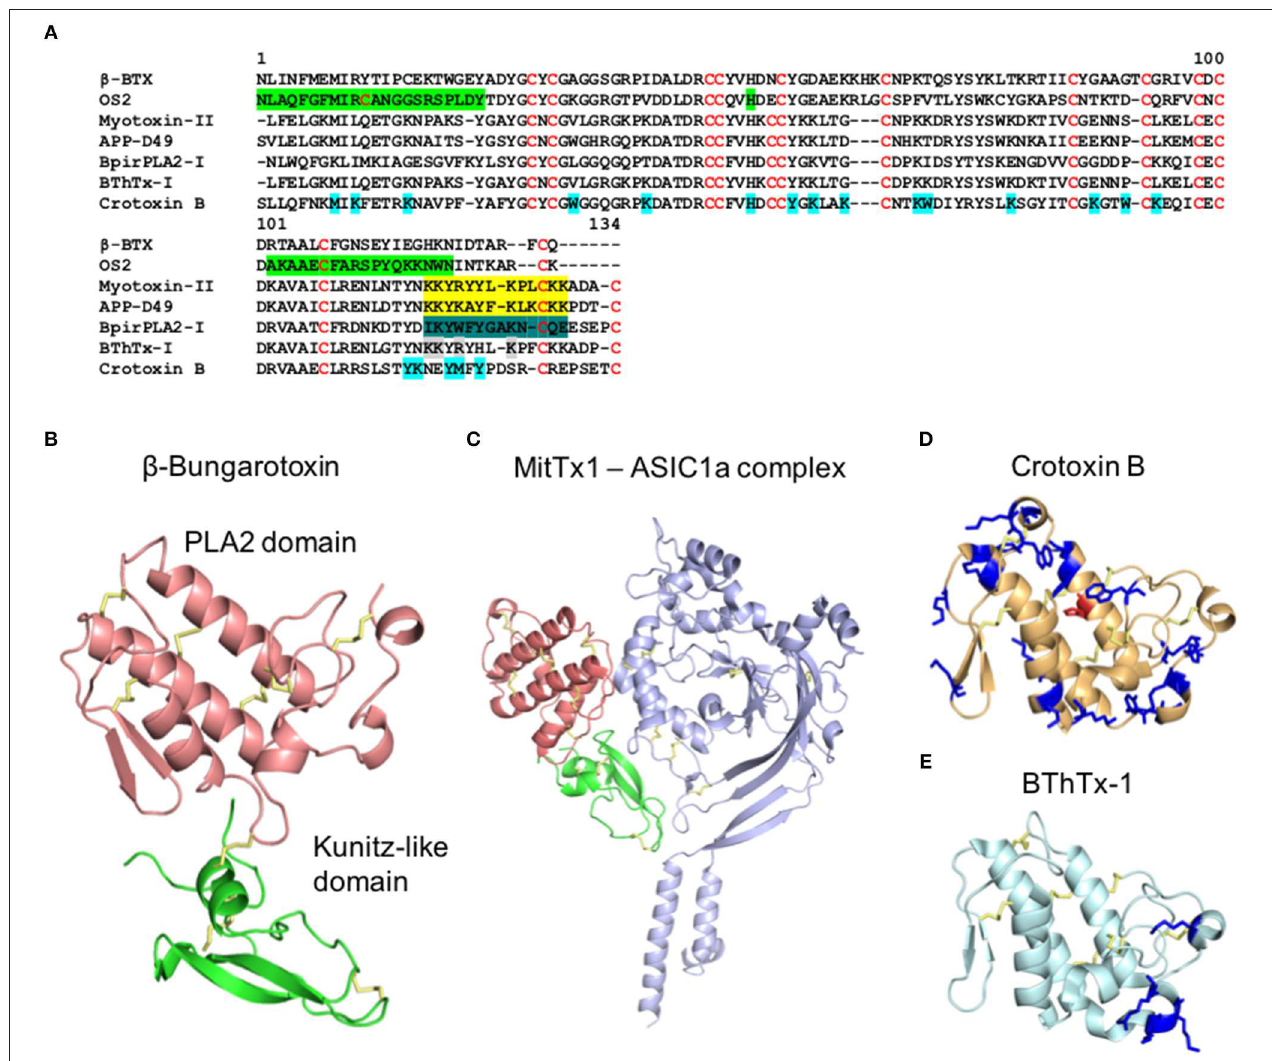
FIGURE 1 | Structure of PLA2s from snake venoms. (A) Alignment of the primary structure of PLA2s from snakes belong to Elapidae (Class I) and Viparinae (Class II). β -Bungarotoxin ( β -BTX) from Bungarus multicinctus (Class I, Basic) (Uniprot P00617), OS2 from Oxyuranus scutellatus (Class I, Basic) (Uniprot Q45Z47), Myotoxin II from Bothrops asper (Class II, Basic) (Uniprot P24605), APP-D49 from A. piscivorus (Class II, Basic) (Uniprot P51972), BpirPLA2-I from Bothrops pirajai (Class II, Acid) (Uniprot C9DPL5), Bothropstoxin-1 (BThTx-I) from Bothrops jararacussu (Class II, Basic) (Uniprot Q90249), and Crotoxin B from Crotalus durissus terrificus (Class II, Basic) (Uniprot P24027). Green: N-terminal region critical for enzymatic and neurotoxic properties, C-terminal region essential for enzymatic activity and central Histidine in the catalytic site (Rouault et al., 2006), Yellow: C-terminal region with myotoxic properties (Lomonte et al., 1994; Nunez et al., 2001), Dark green: C-terminal region with anti-platelet aggregation activity (Teixeira et al., 2011), Gray: Lysin residues involved in the nociceptive, and/or endematogenic properties (Zambelli et al., 2017a) and Cyan: modified residues in the Crotoxin B which lead to alterations in the enzymatic, toxic, and pharmacological properties (Soares et al., 2001). (B–E) Cartoon representation of the three-dimensional structure of (B) β -Bungarotoxin with the PLA2 domain in red and knutiz domain in green (PDB 1BUN), (C) MitTx1 and ASIC1a channel complex with PLA2 domain in red, knutiz domain in green and ASIC1a channel in blue (PDB 4NTY), (D) Crotoxin B (PDB 2QOG) and (E) BThrTx1 (PDB 3HZD). (D,E) Highlighted in blue are the amino acids positions involved in the enzymatic, toxic and pharmacological properties of Crotoxin B (Soares et al., 2001) and in the nociceptive and/or endematogenic properties in BThrTx1 (Zambelli et al., 2017a). The central histidine in the catalytic site of Crotoxin B is highlighted in red.